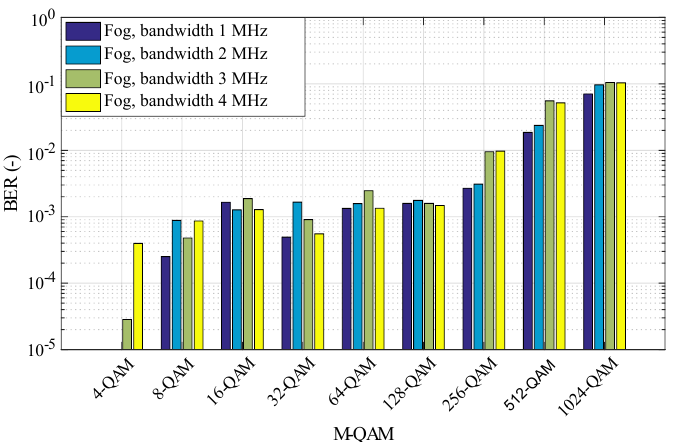
Figure 36. BER/distance relationship for Octavia tail-light with different M-QAM and bandwidths—in scenario 5—fog.